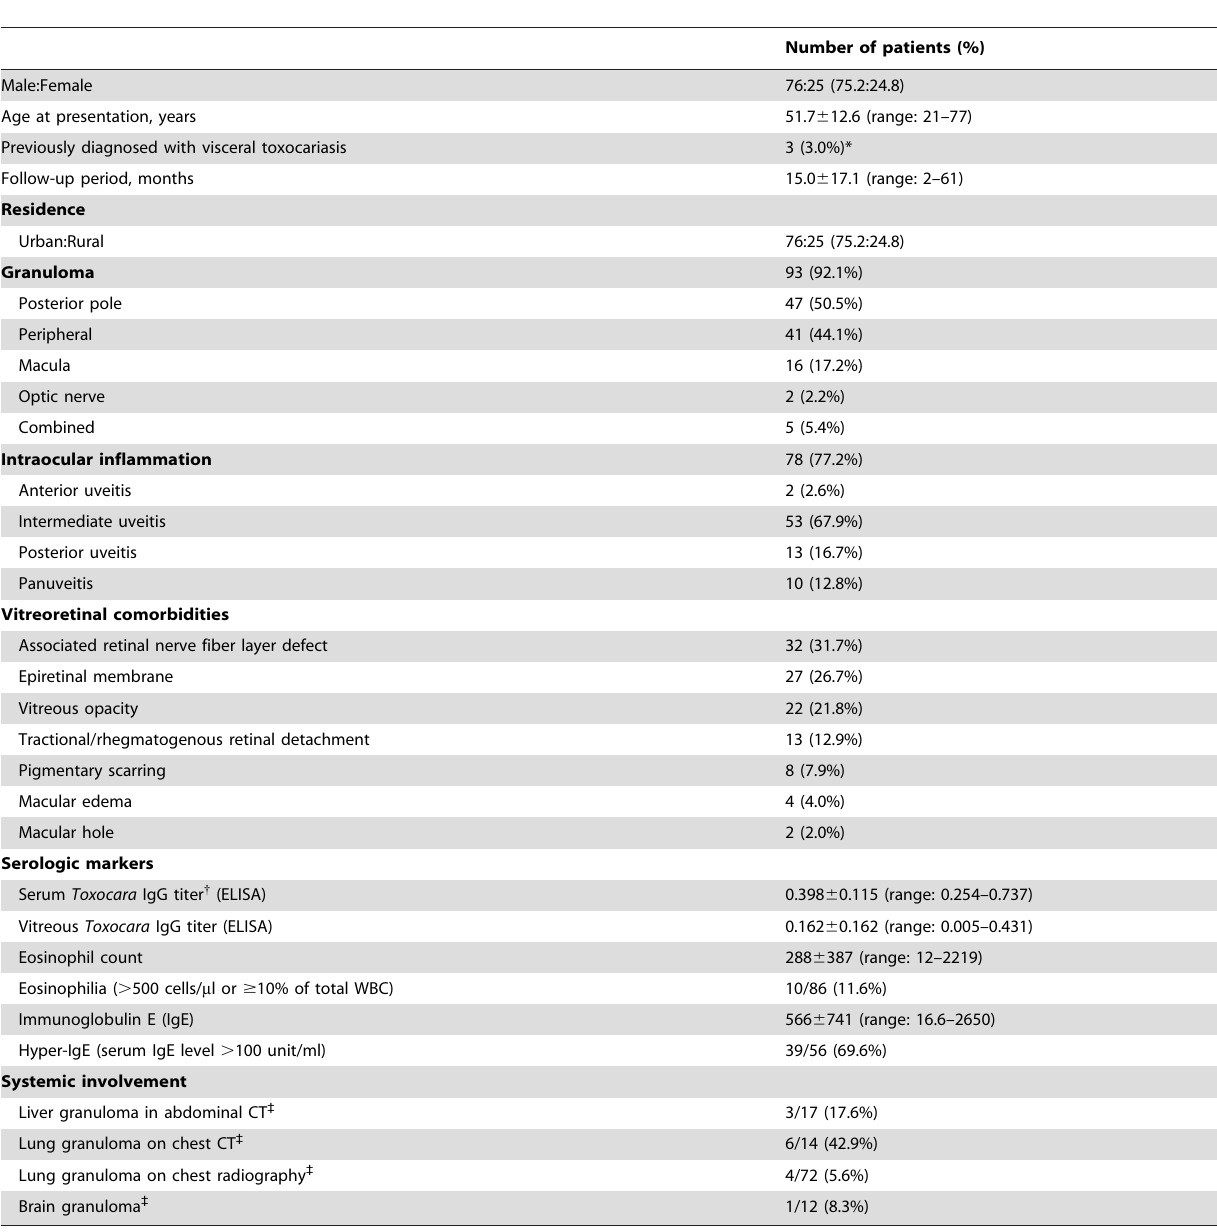
Table 1. Demographics, clinical characteristics, and serologic markers in adult patients with ocular toxocariasis.